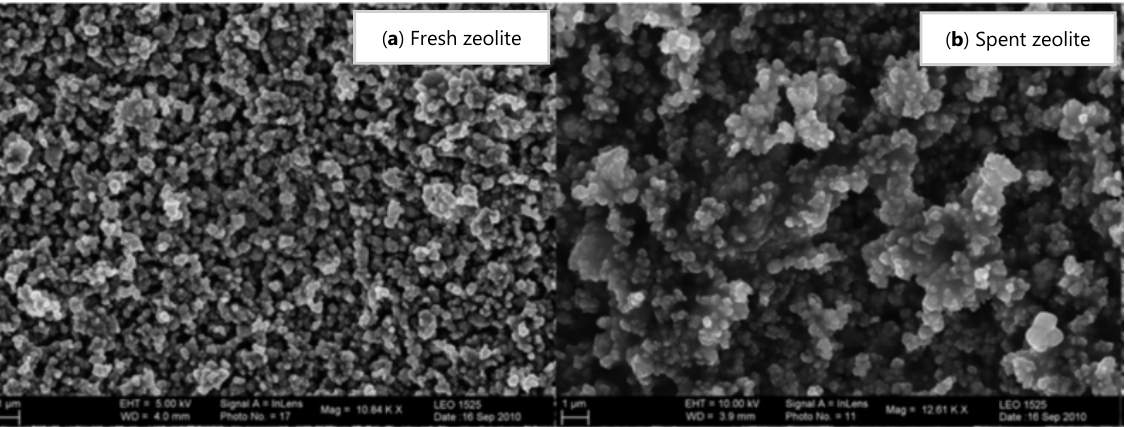
Figure 18. SEM images of fresh ( a ) and aged ( b ) ZSM-5 zeolite used for catalytic pyrolysis of plastic wastes. Adapted from Lopez et al. [79].